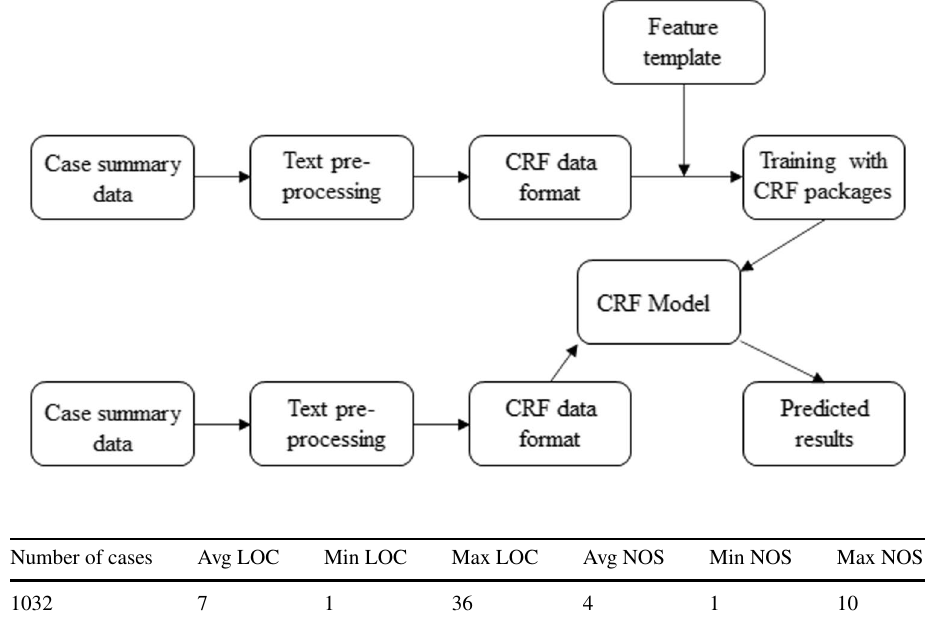
Fig. 5 Extraction of criminal suspects based on CRF technol- ogy